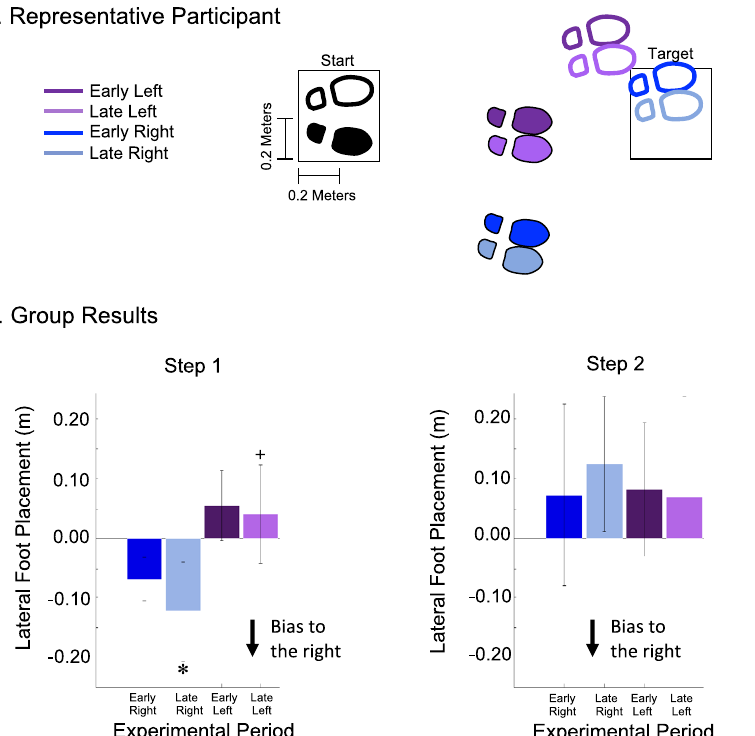
Figure 7. Lateral foot placement ( A ) Representative participant and ( B ) Statistical results ( A ) Foot placement during select trials from analysis periods for a single representative participant. Filled in footprints represent the right foot and outlined footprints represent the left foot. Black and white footprints show feet at start position and colored footprints show step one and step two, respectively. ( B ) Mean ± SD for lateral foot placement across experimental period. X-axis labels: ER, EL, LR, and LL represent periods early right, early left, late right, and late left respectively. Significance ( p < 0.05) from early field right is denoted by ( ✽ ) and significance ( p < 0.05) from early field left is denoted by ( +). For step one, outcomes from the two-by-two ANOVA identified a significant main effect of both experimental period ( p < 0.001), indicating that steps were placed more to the right during late field trials relative to early field trials, and direction ( p < 0.001), indicating that force field right lateral foot placement was placed farther to the right than force field left, along with no significant interaction between experimental period and direction ( p = 0.197). For step two, outcomes for the two-by-two ANOVA found no significant main effect of experimental period ( p = 0.700) or direction ( p = 0.350) and no significant interaction effect between experimental period and direction ( p =